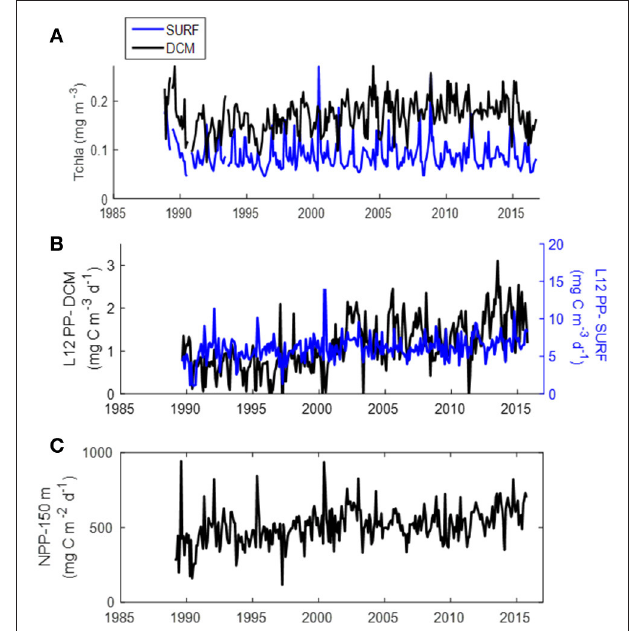
FIGURE 7 | Phytoplankton dynamics at Station ALOHA showing anomalies for (A) T chl a in the surface and deep chlorophyll maximum, DCM, (B) Net primary productivity in the surface (0–45m) and depth (75–150m) as calculated from daytime incubations, and (C) vertically integrated NPP from 0 to